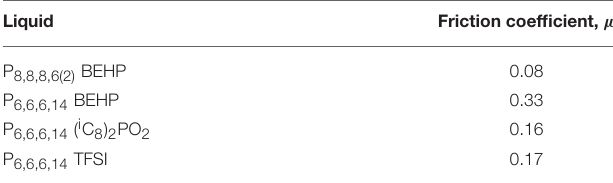
TABLE 2 | The calculated friction coefficients of the ILs measured by